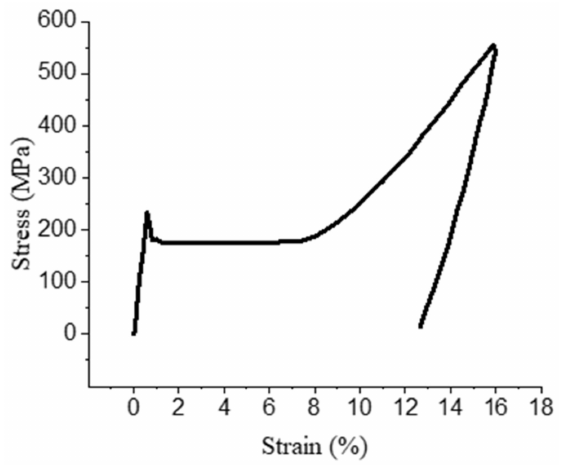
Figure 5. The stress-strain curve of NiTiNb SMA at − 60 ◦ C.